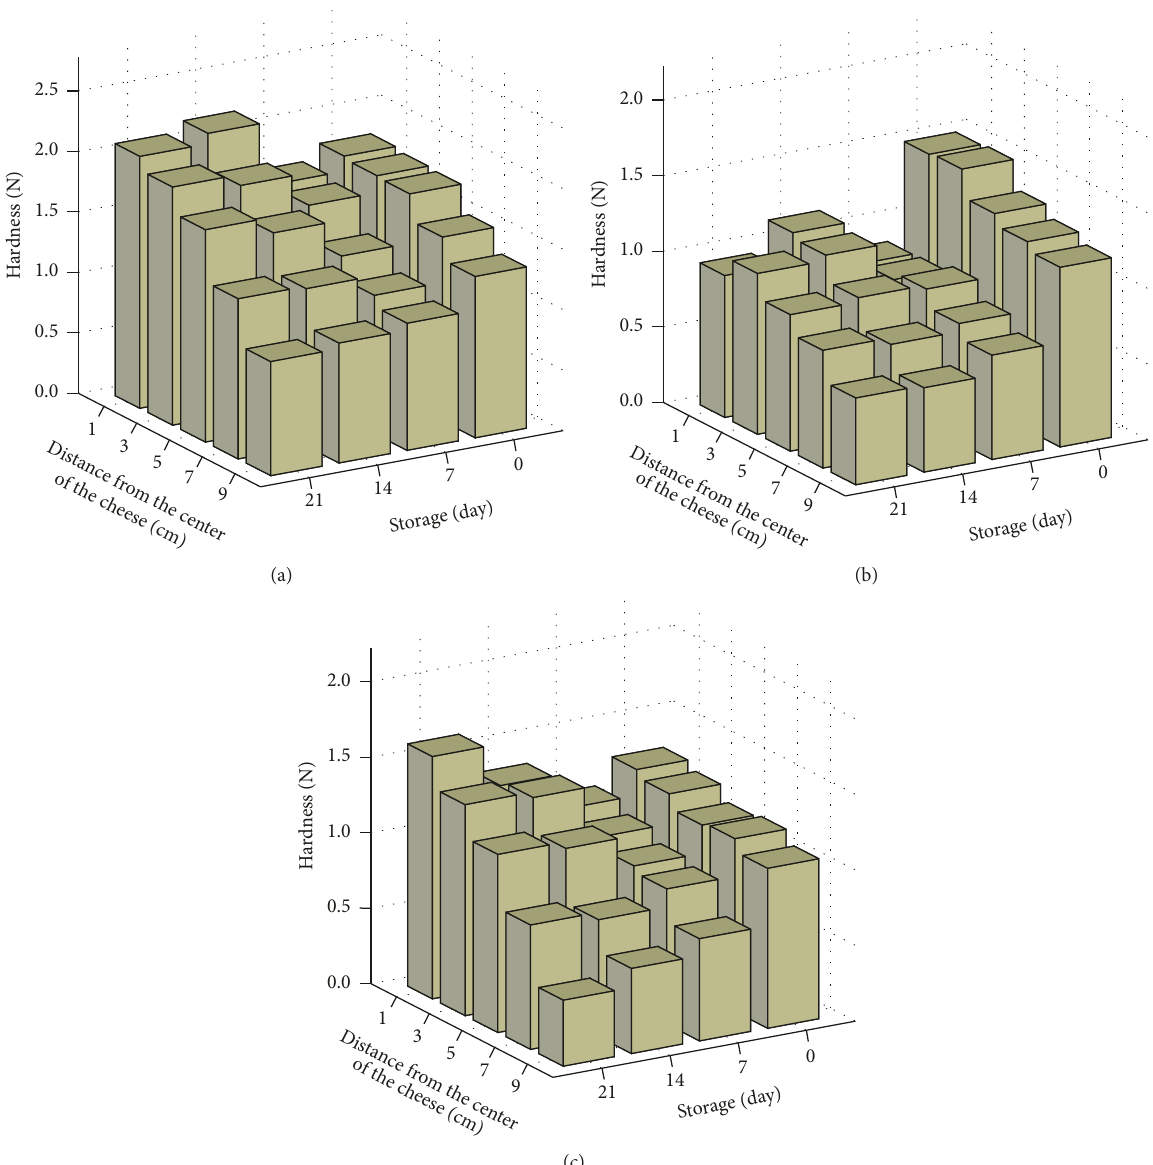
Figure 2: ((a), (b), (c)) Mean values of hardness (N) of Crescenza cheese batches as a function of storage and distance from the central part of the cheese block. Crescenza C (a) was manufactured using the same direct-to-vat starter culture of St. thermophilus and a fermentation- produced camel chymosin (FPCC). Crescenza N (b) was manufactured using a direct-to-vat starter culture of St. thermophilus and calf rennet. Crescenza S was manufactured using the same calf rennet of Crescenza N and a bulk starter culture of St. thermophilus